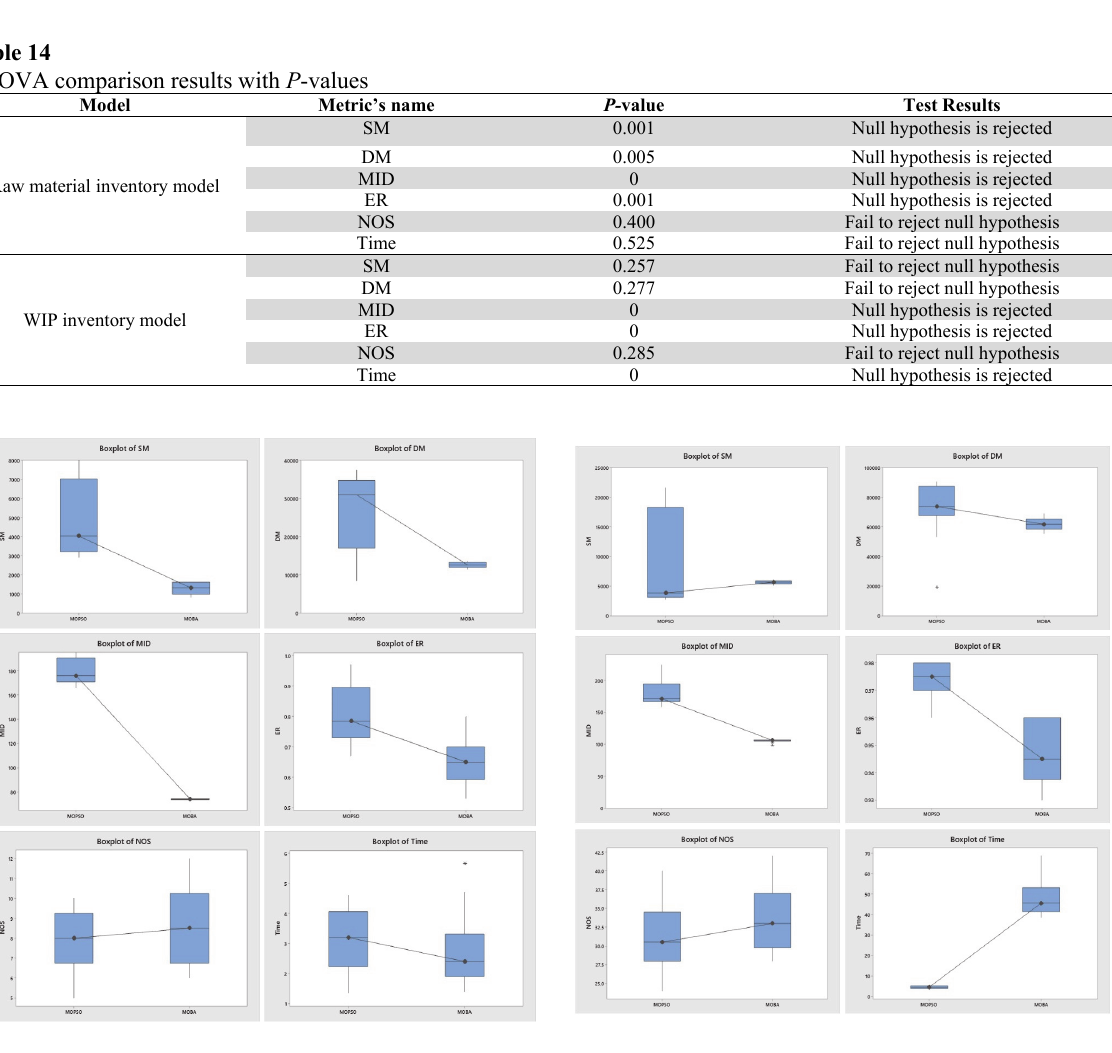
Fig. 9. Boxplots of metrics vs. algorithms (raw material inventory model)